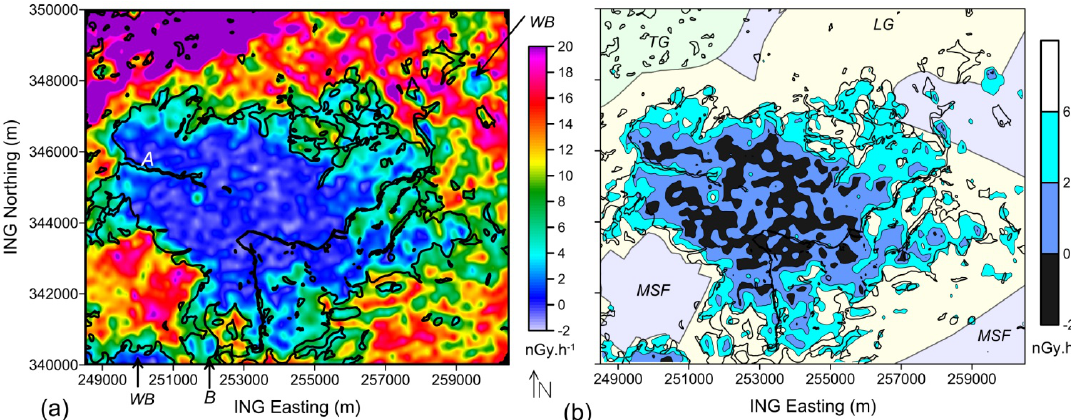
with transparency. Although the particular peat boundary used is not definitive; it provides a necessary broad reference for the geophysical response. Zones (A) identify a number of areas where the DOSE threshold of 6 nGy·h − 1 does not extend to the reference peat boundary. The DOSE threshold of 6 nGy·h − 1 also extends into the perimeter HG and HR soils at a number of locations. Figure 9. The 12 × 10 km study area across the Slieve Beagh blanket bog in both Northern Ireland and the Republic of Ireland. ( a ) Radiometric DOSE data shown as continuous colour image, limited to 20 nGy·h − 1 . Black contours denote peat locations. Two water bodies are labelled WB. Areas “A” and “B” are discussed in the text. ( b ) Radiometric DOSE data shown as contours, limited to 6 nGy·h − 1 . Black contours denote peat locations. Infill background colours denote bedrock geology: LG (Leitrim Group), MSF (Marine Shelf Facies), TG (Tyrone Group).